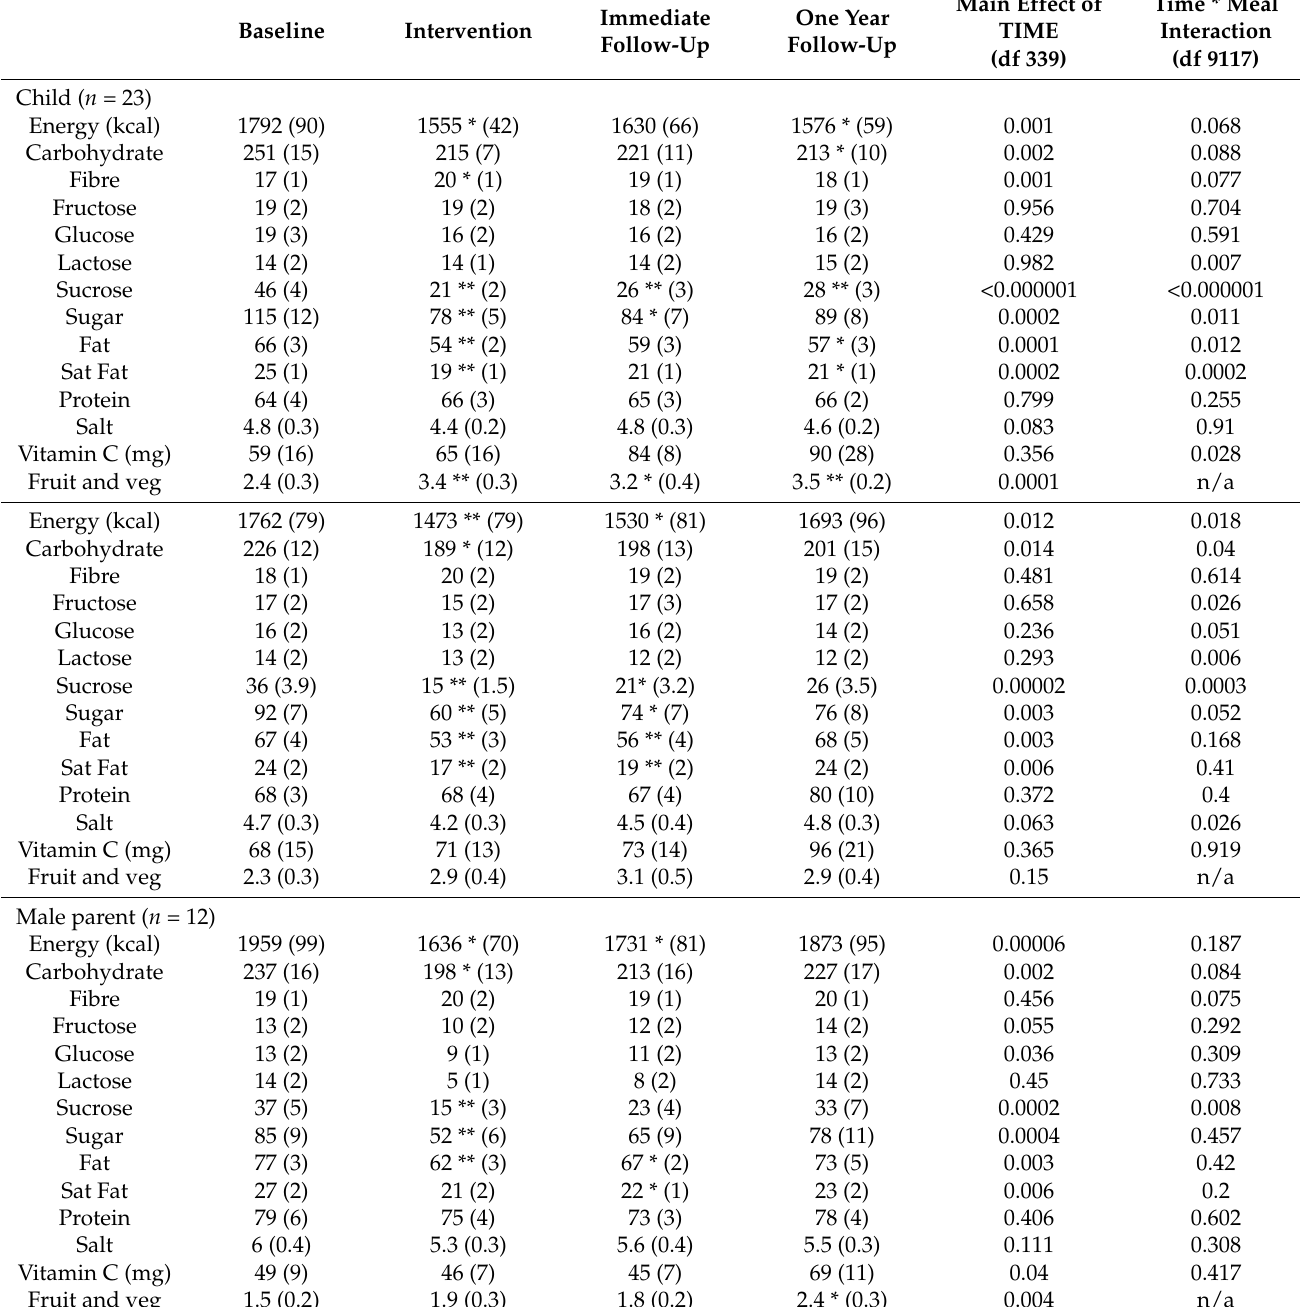
Table 2. Mean (se) daily intake per person (g) calculated from a maximum period of 14 days, fruit and veg = portion (80 g). * ( p < 0.05) and ** ( p < 0.01), significant difference from baseline following Bonferroni corrected post hoc tests. Mean (range) number of days data per family for each stage